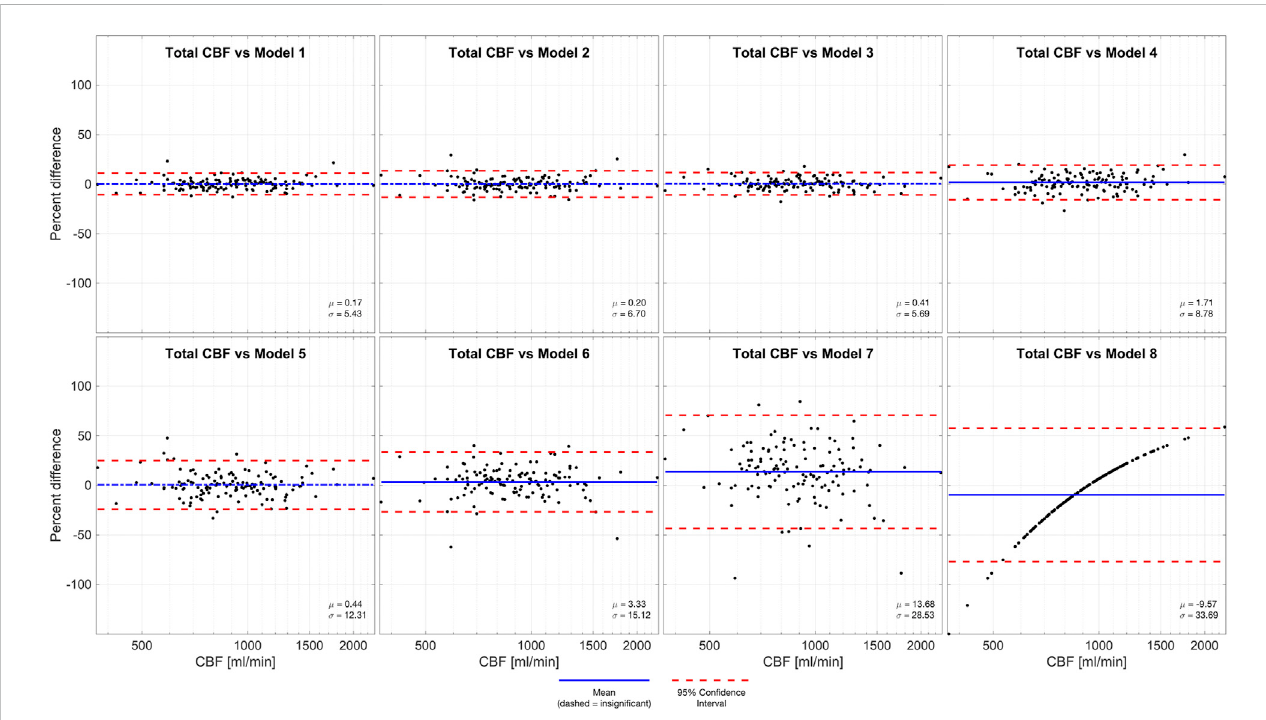
FIGURE 2 Bland-Altman analysis of total CBF quanti fi ed by PC in four vessels (model 0) versus various models of one or more missing vessels. Blue line demonstratesbias,dashedbluelinedemonstratesinsigni fi cant( p > 0.05)bias,andreddashlinesdemonstrate95%con fi denceintervals.Theseresultssuggest that it is important to successfully capture at least one ICA or both VAs to impute CBF